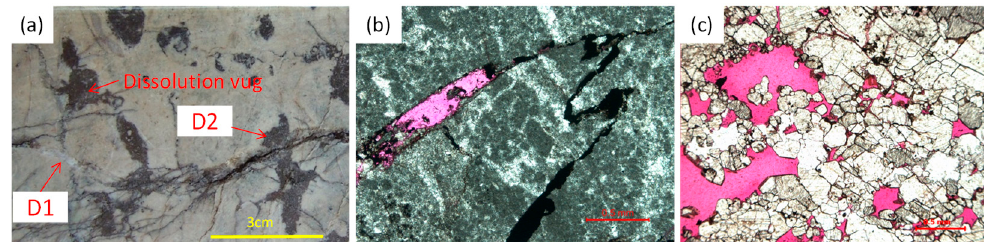
Figure 8. Photographs showing dissolution in the carbonate fault damage zones in the Halahatang area (the pink-dye resin showing the porosity). ( a ) Multiple dissolution in cores, the first dissolution (D1) porosity is occluded by calcite cements, the second dissolution (D2) porosity and vugs are filled with cements and bitumen, the late fracture (under arrow of D2) reactivation and opening possibly suggest third stage dissolution; H601-1, core, 6638 m; ( b ) dissolution porosity along a stylolite, H601-18, thin section, 6755.04 m; ( c ) dissolution porosity among the cataclasites, H803, thin section, 6573.78